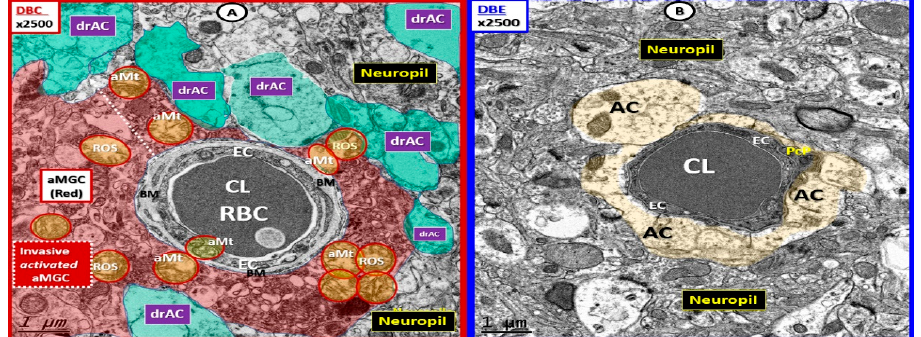
Figure 3. The basement-membrane-thickening, activated microglia invasion and detached, separated astrocyte foot processes are protected with empagliflozin. ( A ) The invasion of the activated microglia cell (aMGC) to totally engulf the neurovascular unit (NVU) (uncolored) with a detachment-separation of the AC end foot processes (drAC = detached, retracted, and separated astrocyte; pseudo-colored green). Also note the aberrant mitochondria (aMt) (pseudo-colored yellow with red outline) in DBC, which may be responsible for Mt-derived reactive oxygen species (ROS) production and leakage. ( B ) In DBE, the empagliflozin protects the NVU from aberrant remodeling in the DBC as seen in Figure 3A. Note the intact AC end feet (pseudo-colored golden) and that the mitochondria in DBE are electron dense and not aberrant as in the DBC. Magnification ×2500; scale bar = 1µm. aMGC = activated microglia cell; aMt = aberrant mitochondria; drAC = detached retracted AC EC = endothelial cell; CL = NVU capillary lumen; Pc = pericyte foot process; RBC = red blood cell; ROS = reactive oxygen species. Available via license CC BY 4.0.